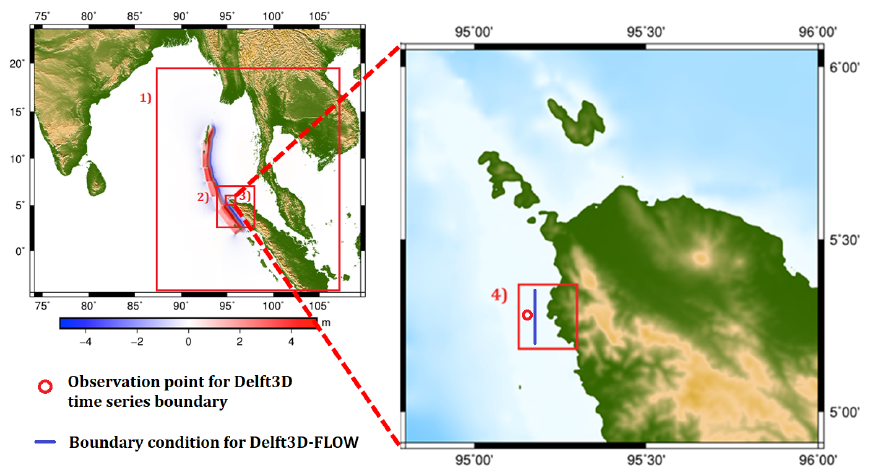
Figure 3. Nested simulation layers incorporated into COMCOT and the boundary condition location for the Delft3D simulation (a solid blue line) in layer 4. Table 1. Specification of layers applied in the COMCOT simulation. Layer Longitude ( ◦ ) Latitude ( ◦ ) Grid Type of Coordinate